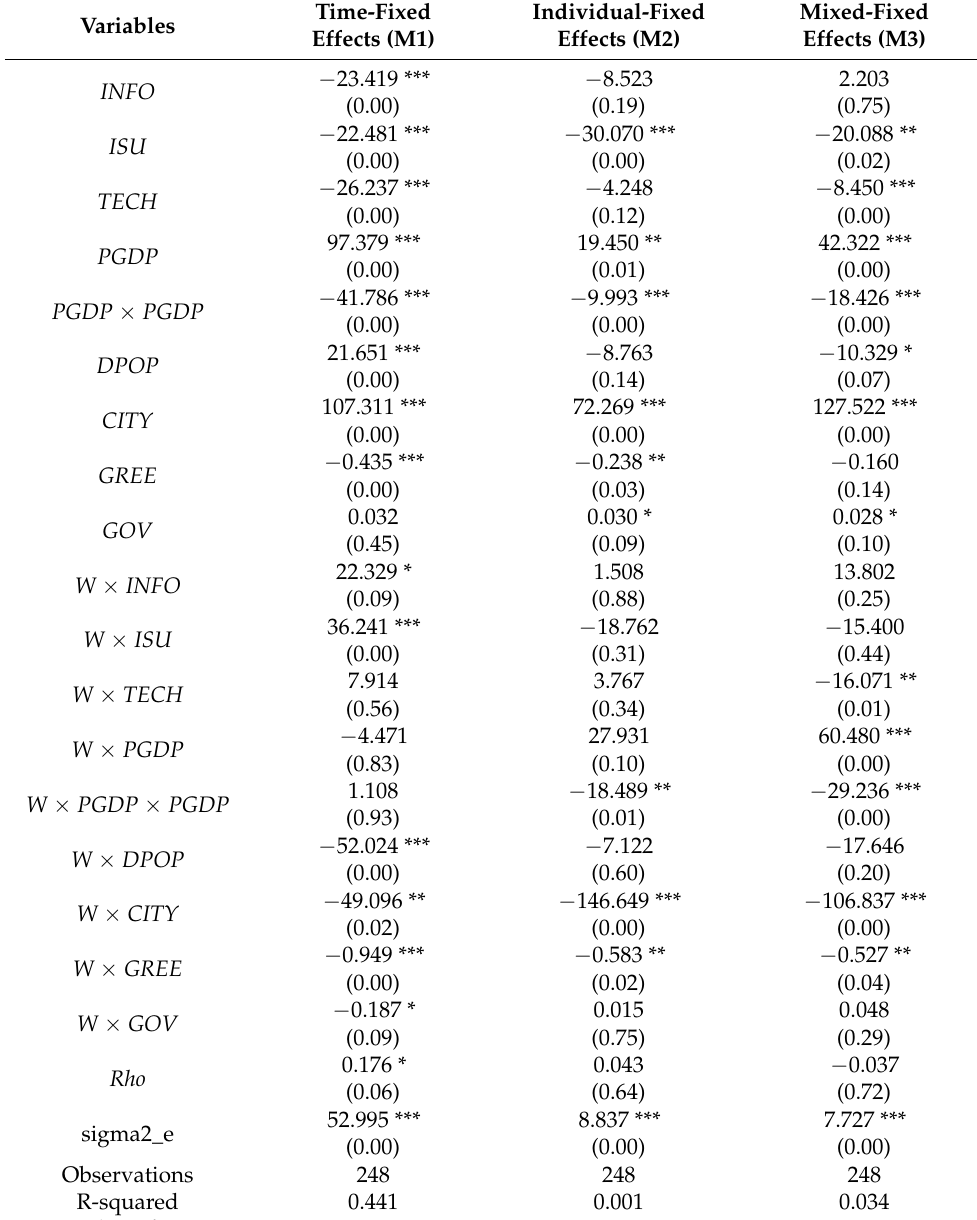
Table 4. Regression results of the